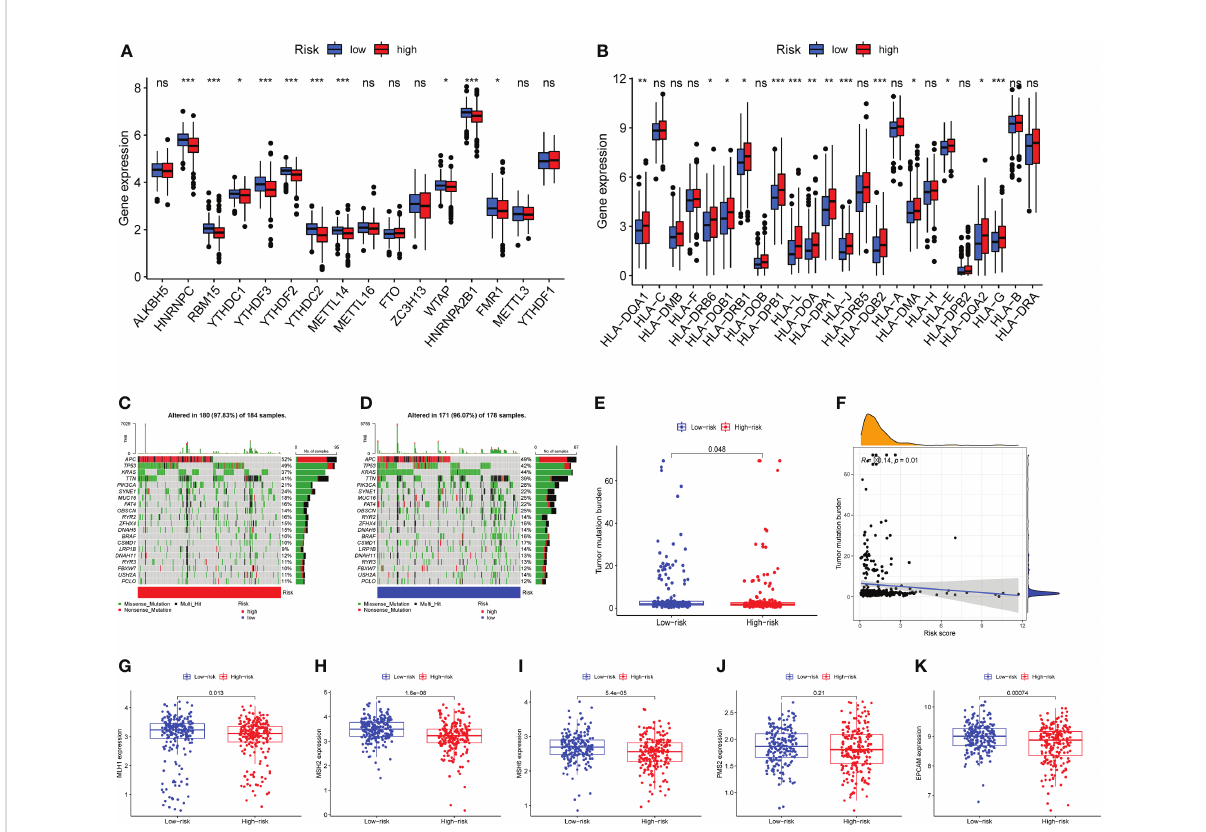
FIGURE 7 Expression analysis of m 6 A-related genes and human leukocyte antigen (HLA) related genes, mutation analysis. (A) Differential expression of m 6 A-related genes HNRNPC, RBM15, YTHDC1, YTHDF3, YTHDF2, YTHDC2, METTL14, WTAP, HNRNPA2B1, FMR1 were observed between the high-risk group and the low-risk groups. (B) The human leukocyte antigen gene analysis. HLA-DQA1, HLA-DRB6, HLA-DQB1, HLA-DRB1, HLA- DPB1, HLA-L, HLA-DOA, HLA-DPA1, HLA-J, HLA-DQB2, HLA-DMA, HLA-E, HLA-DQA2, and HLA-G were observed to be differentially expressed between high-risk and low-risk groups. (C) The mutation landscape of the high-risk group and draw the results into a waterfall diagram. (D) The waterfall diagram shows the mutation of patients in the low-risk group, and the mutation rate of APC was also highest. (E) Tumor mutation burden (TMB) analysis between the two risk groups. (F) Pearson-correlation analysis showed that there was a signi fi cant negative correlation between TMB and risk score. (G – K) Expression analysis of mismatch repair (MMR) protein. The expressions of MLH1, MSH2, MSH6 and EPCAM were signi fi cantly up-regulated in the low-risk group, while the expression of PMS2 showed no statistical difference between the two risk groups. ns, not signi fi cant,*P < 0.05, **P < 0.01, ***P <